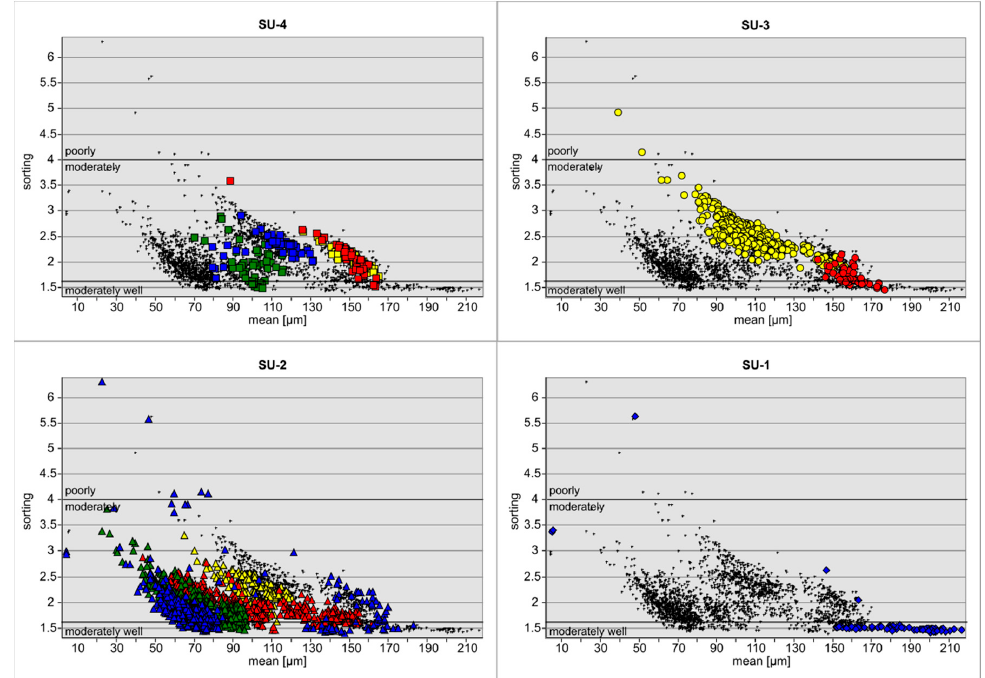
Figure 9. The bivariate plots show the relation between the mean grain size and the sorting for the four seismic units (SU). The colors represent the coring station (1: yellow, 2: red, 3: green, 4: blue). Black dots represent the complete data set (all SU).